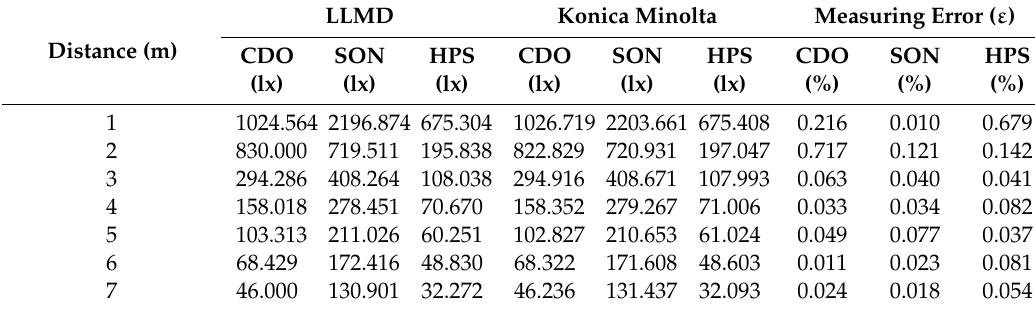
Table 6. Comparative measurements lighting level.